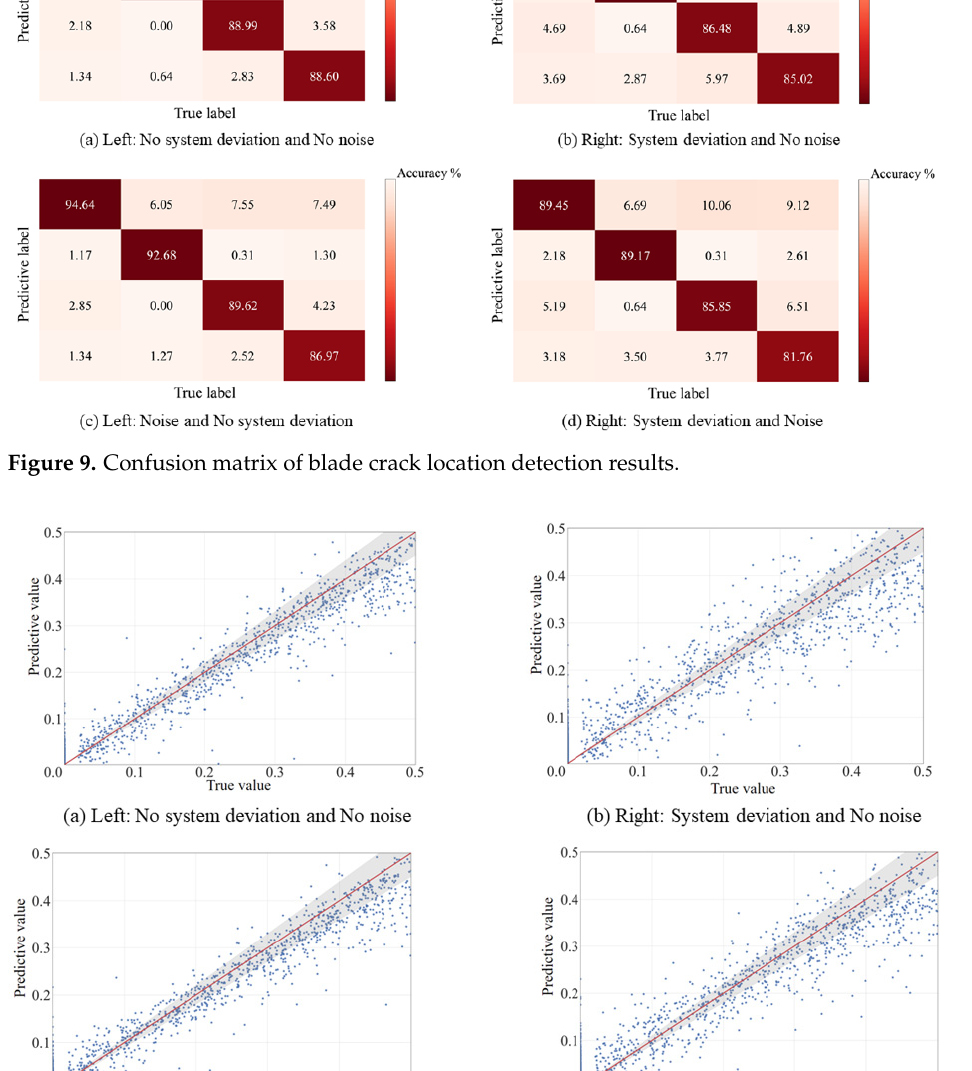
Figure 11. Campbell diagram of modal frequency of model blade.